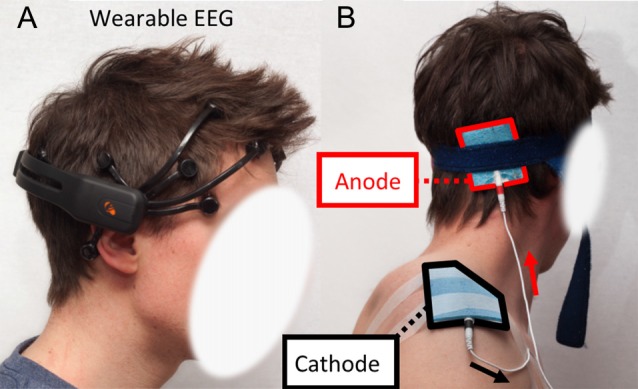
(A) Emotiv Epoc electroencephalogram (EEG) headset installed on the skull of a subject. (B) Electrodes placement for anodal transcranial Direct Current Stimulation (atDCS). Anode is located halfway between the inion and the mastoid process. Cathode is on the acromion.